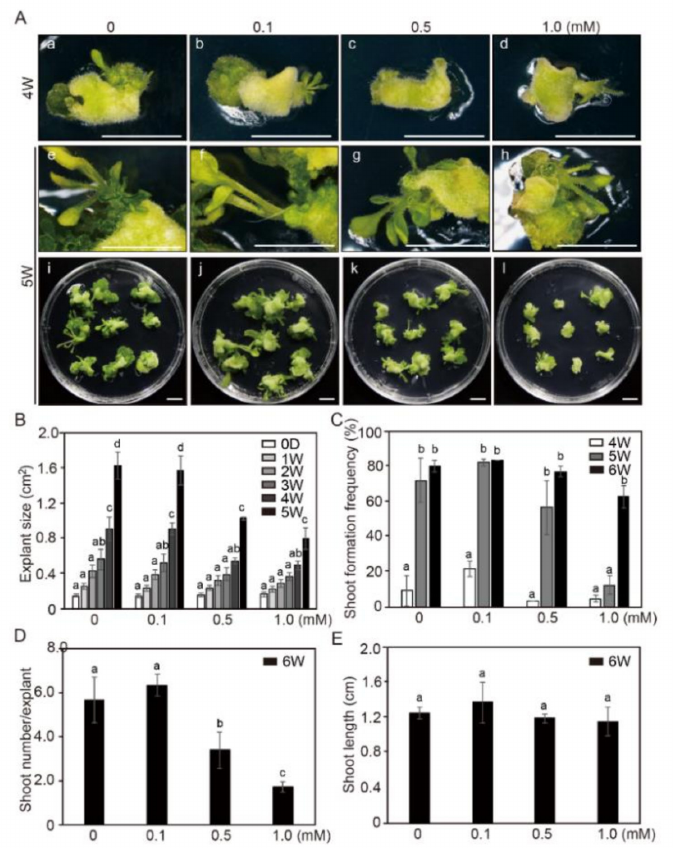
Figure 2. The e ff ect of sodium butyrate (NaB) on adventitious shoot formation in cotyledon explants of tobacco. ( A ) Explant growth and adventitious shoot formation in the shoot induction medium (SIM) containing 0, 0.1, 0.5, and 1.0 mM of NaB after 4 (a–d) and 5 (e–l) weeks of culture. Scale bars = 1 cm. The size of cotyledon explants ( B ), the frequency of adventitious shoot formation ( C ), the shoot numbers per cotyledon explant ( D ), and shoot length ( E ) in the SIM containing 0, 0.1, 0.5, and 1.0 mM of NaB. Three independent experiments were performed on 81 explants. Error bars represent SD (N = 81). Di ff erent letters on the bars indicate significant di ff erences between each treatment (ANOVA followed by a Tukey’s test, p < 0.05). D = day; W =